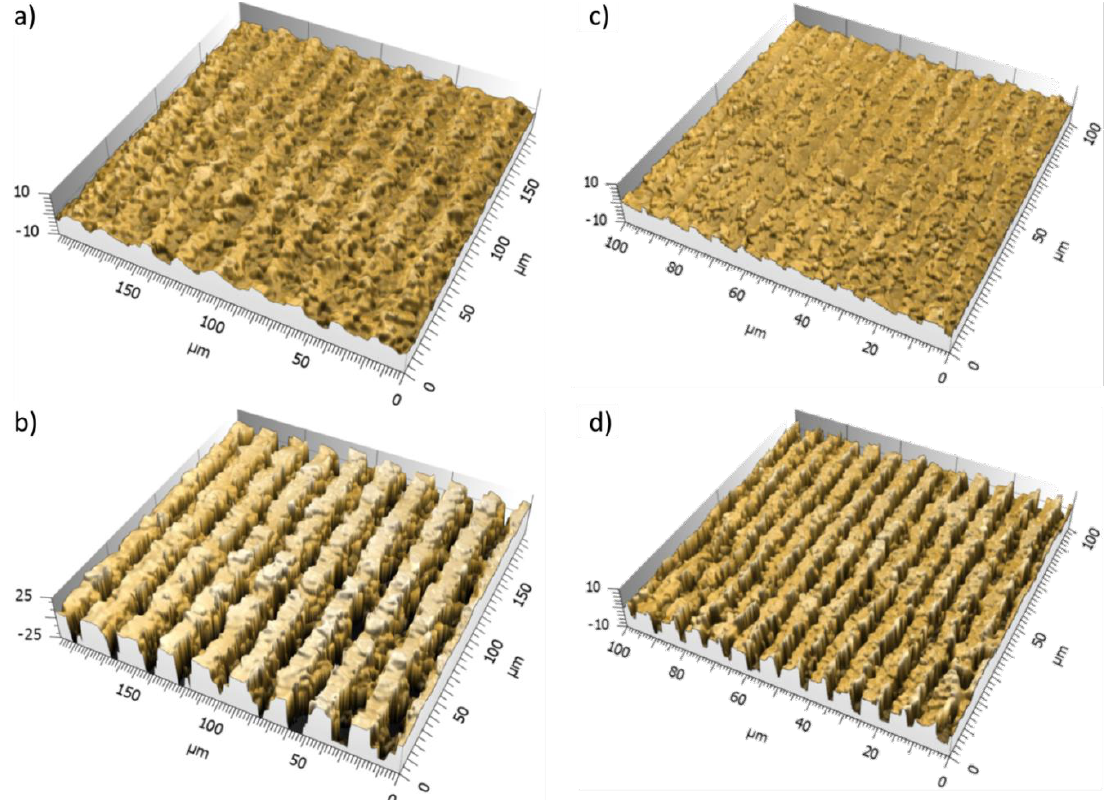
Figure 3. Confocal microscope images of DLIP structured aluminum surfaces with interference periods of ( a , b ) Λ = 19.0 µm and ( c , d ) Λ = 8.0 µm, fabricated using pulse overlaps ( a , c ) PO = 80% and ( b , d ) PO = 99%. The laser fluence was 3.2 J∙cm −2 . Material: aluminum EN AW-5754 AlMg3 [43].